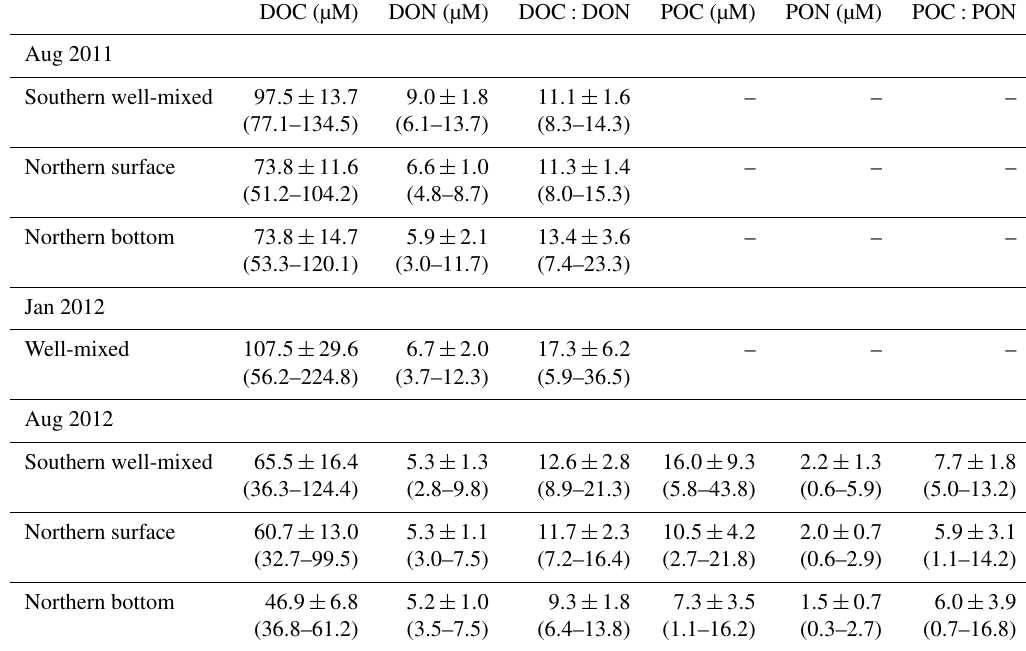
Table 3. Summary of dissolved organic carbon and nitrogen observations in this